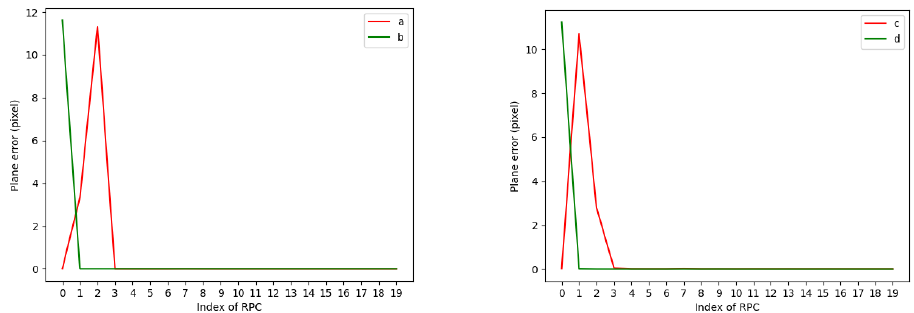
Figure 3. Errors affected by RPCs with numerical accuracy of 0.01 r.